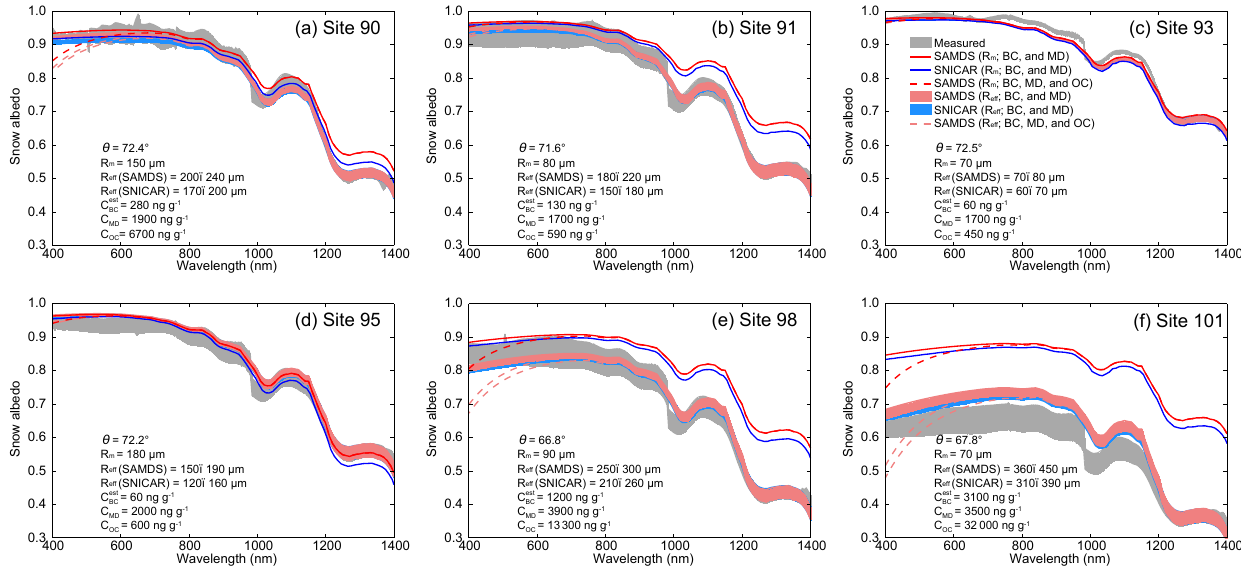
Figure 11. Measured and modeled spectral albedos of snow at sites (a) 90, (b) 91, (c) 93, (d) 95, (e) 98, and (f) 101. Shaded gray bands correspond to measured spectral albedos using spectroradiometer. Solid red and blue lines correspond to spectral albedos simulated by the SAMDS and SNICAR models with measured snow grain radii ( R m ) , and shaded light red and blue bands correspond to the albedos with calculated snow grain optical effective radii ( R eff ) . Contaminants only include BC and MD in the SAMDS and SNICAR models. In the SNICAR model, the ratio of Fe in dust was assumed to be 2.8%. Dashed red lines are similar to solid red lines, although OC should be added to the list of contaminants in the SAMDS